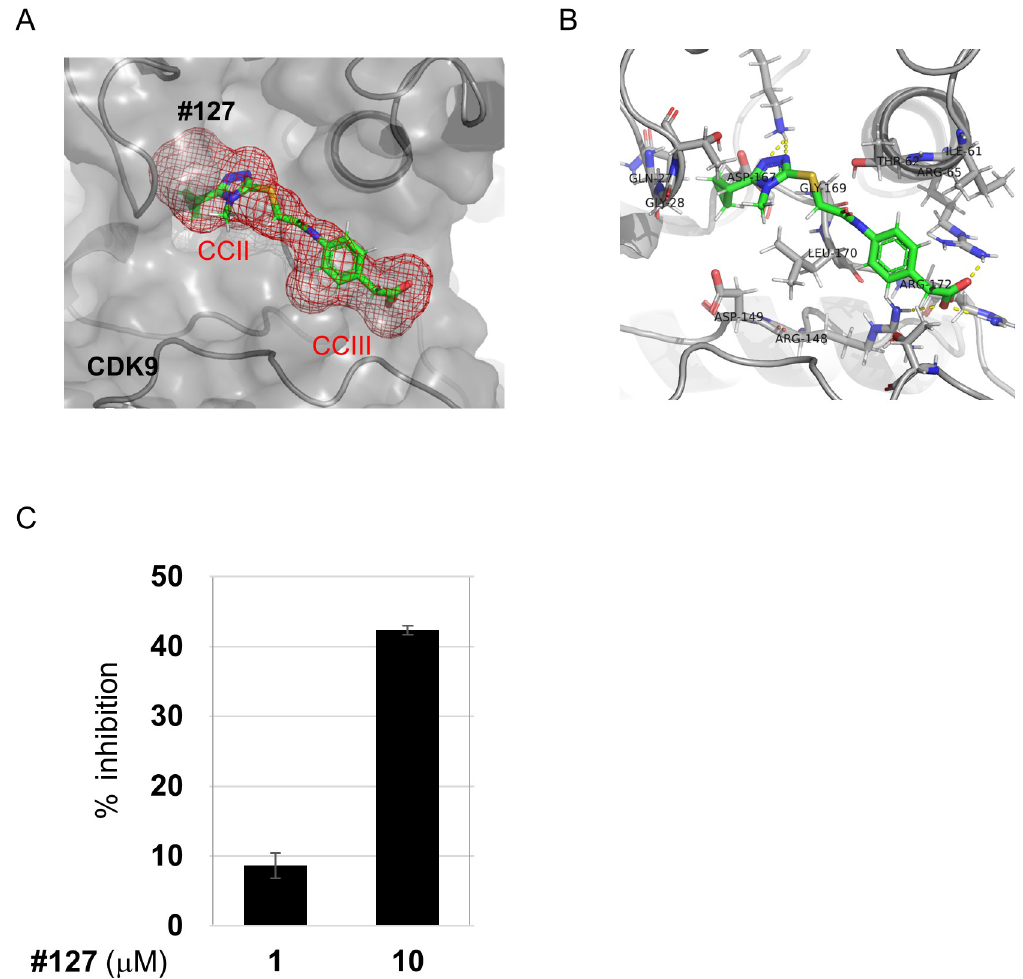
Fig 4. The novel CDK9 inhibitor, compound 127. (A) The predicted binding mode of 127 and CCII and III (red mesh surface) within the CDK9 hidden cavity. (B) Key residues surrounding 127 at the distance of 4.5 Å . (C) The dose-dependent inhibition of CDK9 activity by 127 . Relative kinase activity is shown as % inhibition as described in the Off-chip Mobility Shift Assay (MSA) and data analysis section. Results are shown as means ± SD from 4 independent experiments (n = 4).